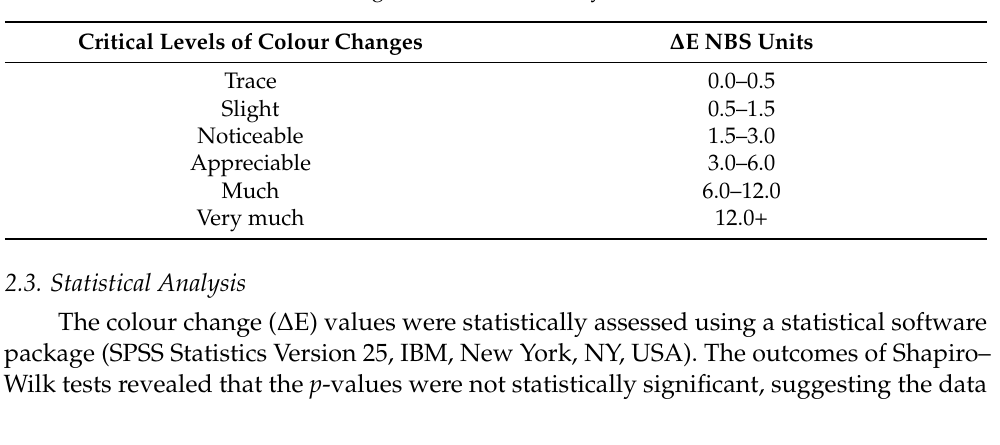
Table 2. Critical levels of colour changes in line with NBS